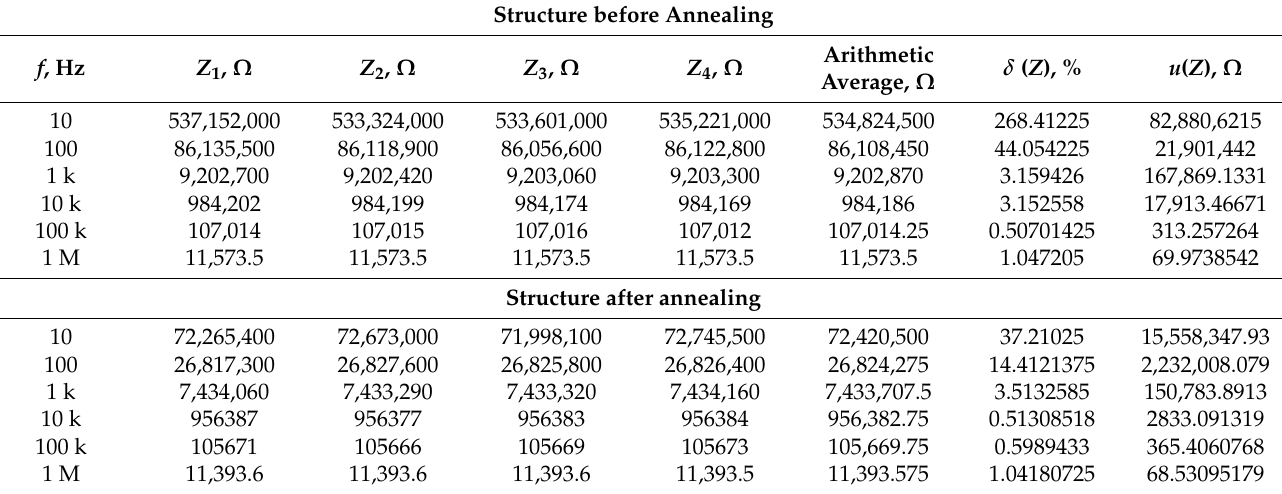
Table 2. List of parameters necessary to determine the standard measurement uncertainty of type B for the measurements of impedance Z